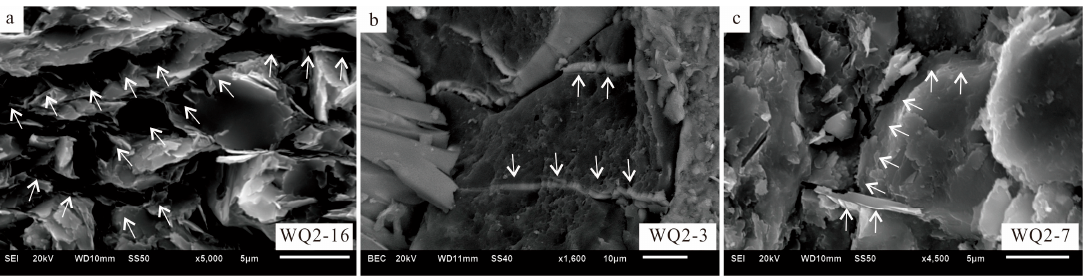
Figure 10. Scanning electron microscope (SEM) images showing fractures and mineral filling.